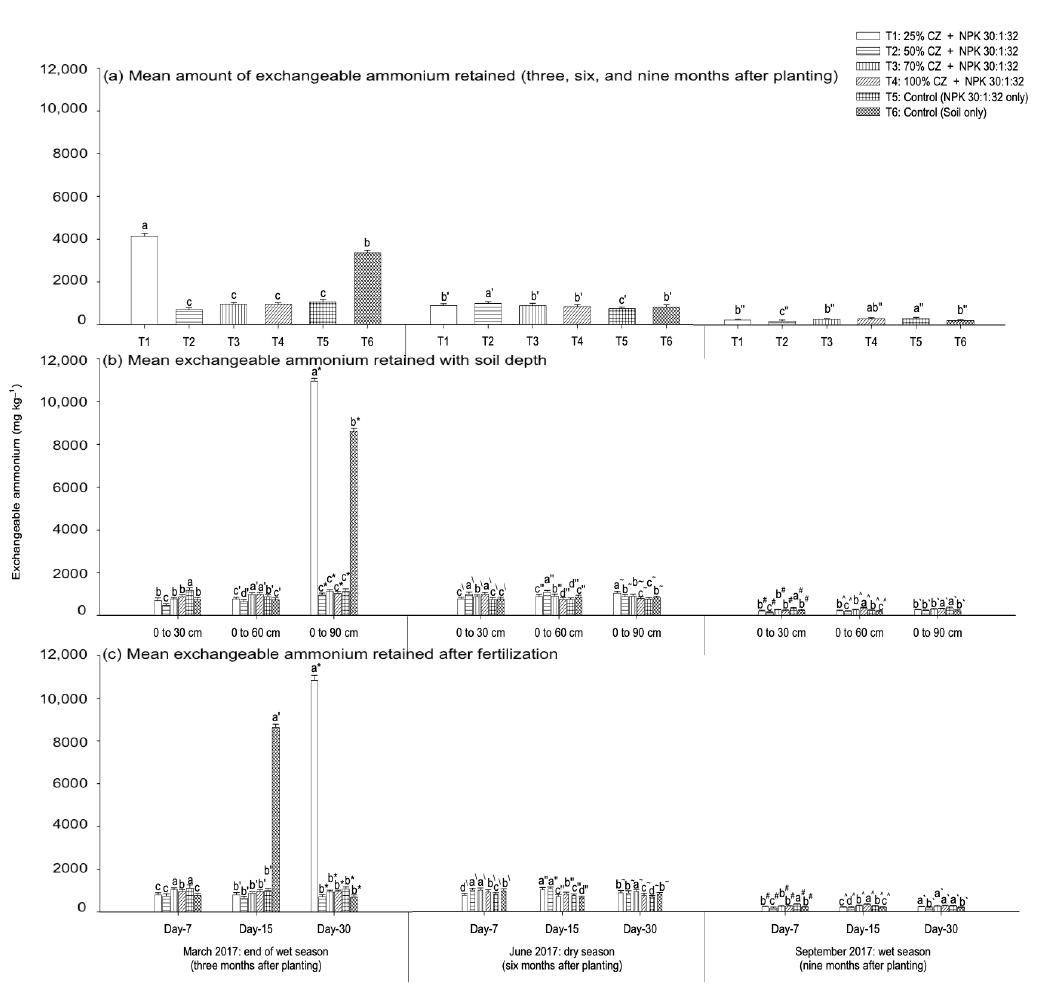
Figure 10. Effects of clinoptilolite zeolite on soil exchangeable ammonium retention at different veg- etative stages (three, six, and nine months after planting): ( a ) mean amount of ammonium retained, ( b ) ammonium retention with soil depth (0 cm to 30 cm, 0 cm to 60 cm, and 0 cm to 90 cm), and ( c ) ammonium retention after fertilization (seven, fifteen, and thirty days) throughout the wet (March and September 2017) and dry (June 2017) seasons. Error bars indicate the standard error of the mean (n=162). Means with different letters are significantly different using Tukey’s test with p ≤ 0.05. CZ: clinoptilolite zeolite. Letters without primes, single primes, and double primes represent mean am- monium retention respectively at three (March 2017), six (June 2017), and nine (September 2017) months after planting. Letters without primes, single primes, and asterisks represent ammonium retention at the end of the wet season (March 2017), letters with backslashes, double primes, and tildes represent the dry season (June 2017), and letters with hashes, carets, and backticks represent the wet season (September 2017).